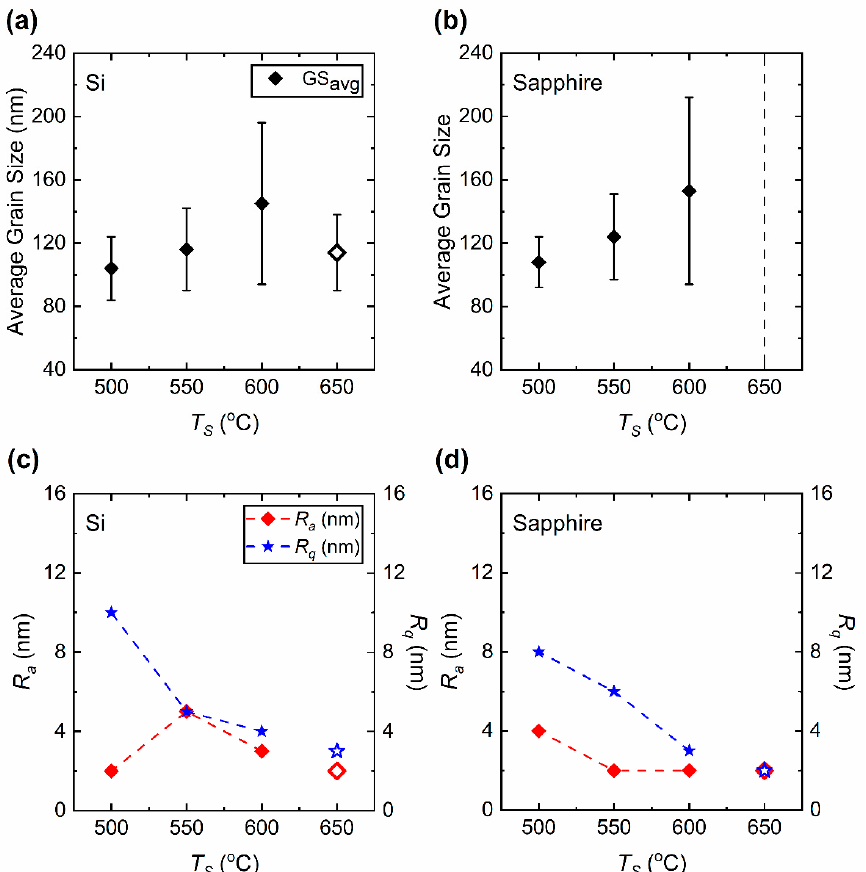
Figure 5. Average grain size (GS avg ) of VO 2 thin films prepared on ( a ) Si and ( b ) sapphire substrates. In ( b ) the dashed vertical line is an asymptote that indicates the near-epitaxial almost flat surface of the film prepared at 650 °C [17]. ( c , d ) present the average ( R a ) and root-mean-square ( R q ) roughness of films prepared on Si and sapphire substrates, respectively. The dashed lines between the data points are guides to the eye. The data points shown in hollow symbols belong to the films prepared at 650 °C (prepared as described in Ref. [17] but not reported therein). Table 2. Average grain size (GS avg ), average ( R a ) and root-mean square ( R q ) roughness of VO 2 thin films prepared at various substrate temperatures ( T S ).